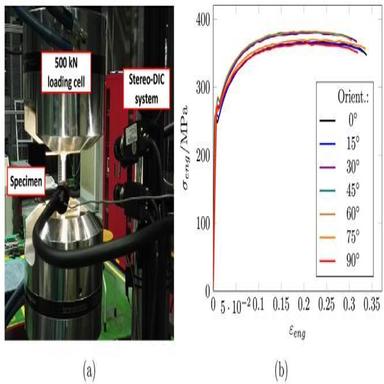
Uniaxial test experimental setup (a). Engineering stress–strain curves obtained at seven different directions from the RD (b).